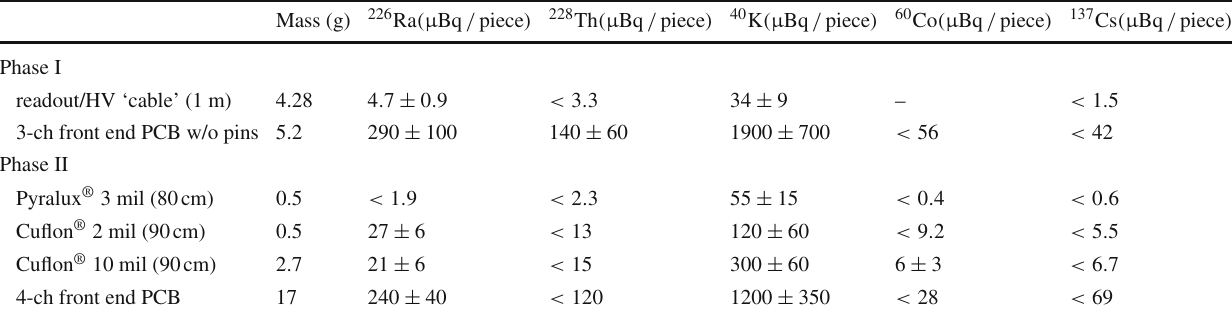
Table7 Theactivityofthe Gerda front-endcablesandPCBsinPhaseI and II. The Phase II front-end PCBs have been screened fully populated while the Phase I samples had no contact pins yet. The values of the